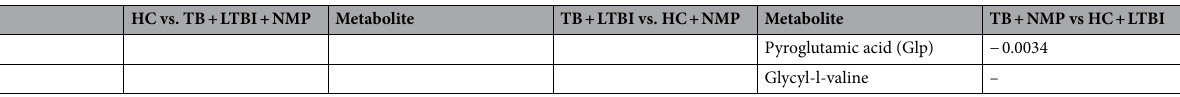
Table 6. The results of 3 elastic-net logistic regression models. The coefficients represent relative differences in serum expression of respective metabolites between the studied groups (under the optimal lambda parameter for the penalty function). The most informative set of markers was chosen based on the fivefold cross- validation approach. The dashes correspond to noninformative predictors. AUC area under curve, HC